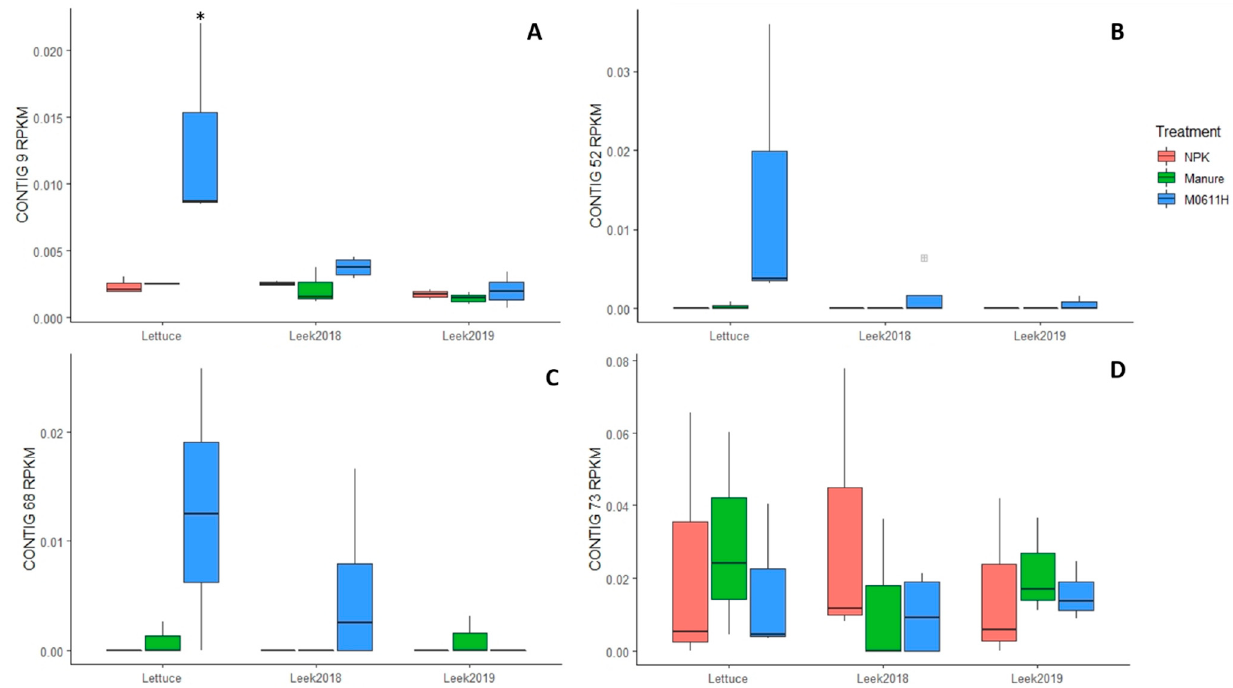
Figure 3. Normalized numbers of E. coli strain 0611 genomic reads, identical to contigs 9 ( A ), 52 ( B ), 68 ( C ) and 73 ( D ), in metagenomes of lettuce, leek 2018 and leek 2019 rhizosphere soils under three soil treatment regimens (manure, M0611H, NPK) and expressed in RPKM values. Average RPKM value marked with * indicate significant difference ( p = 0.001) from other values of the same contig.